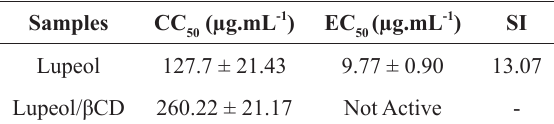
In vitro cytotoxic and antiviral activity of lupeol (5), and inclusion complex